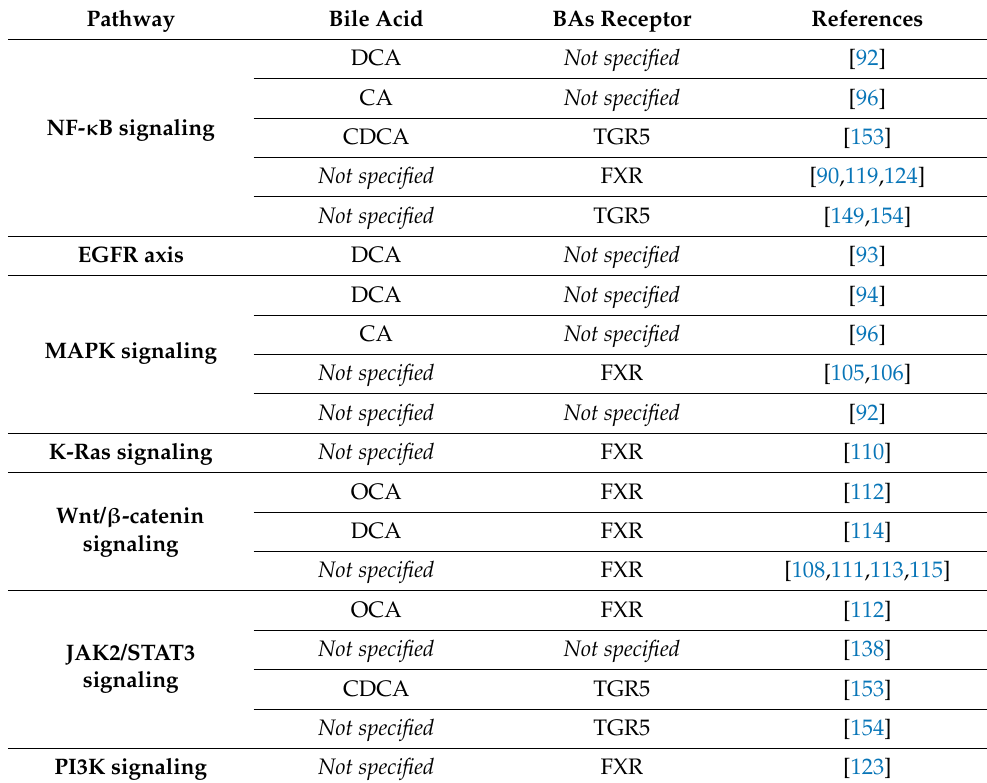
Table 2. Summaries of the main contributions of previous studies describing new insights into BAs-related signaling pathways in the onset of